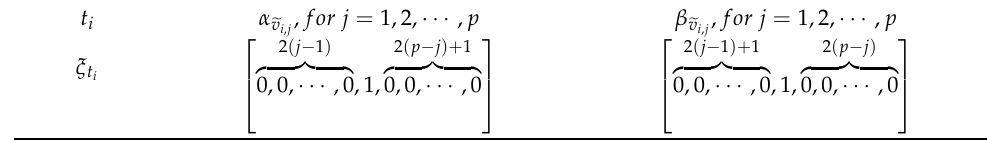
Table 8. ξ for VFCSS applying over symbolic numbers when metric (12) is